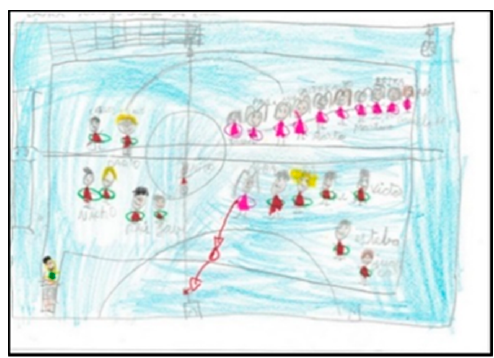
Figure 15. Number of figures present. Laura. 2°B.